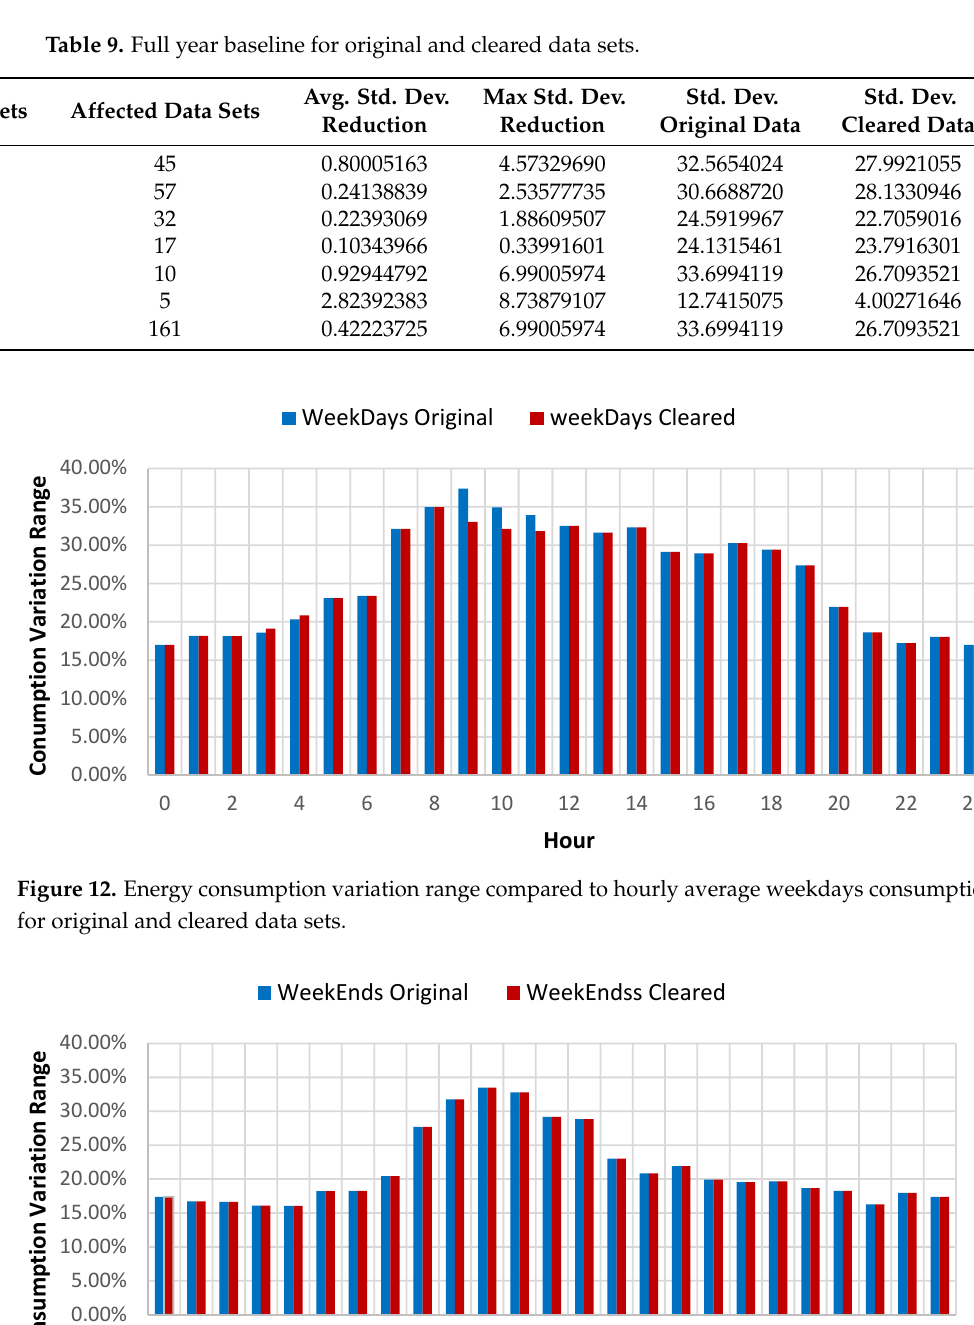
Figure 14. Daily consumption baseline for the original and cleared data sets. 4.2.3. Faculty of Building Services At the Faculty of Building Services location, the results showcased that due to the data cleaning process, a standard deviation (SD) reduction of 0.22% for all days, 0.24% for weekdays and 0.17% for weekend was recorded over the entire historical data sets (see Table 12, Figures 15 and 16).